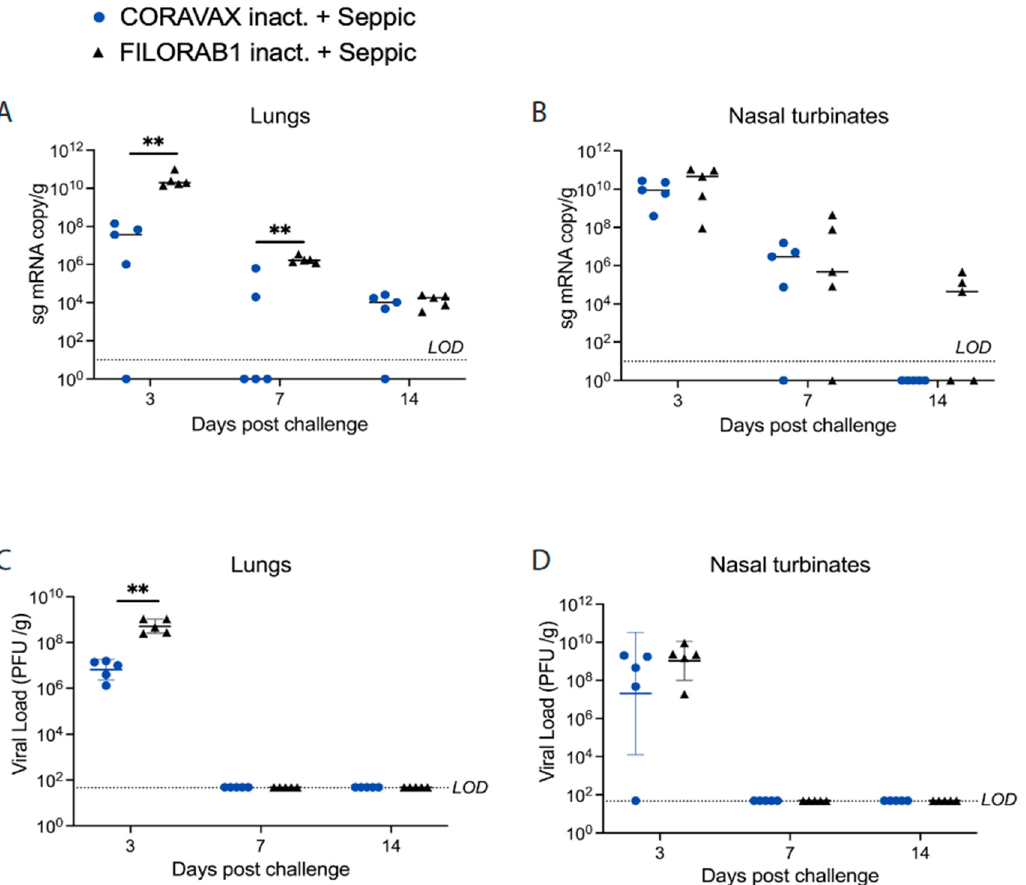
Figure 5. SARS-CoV-2 tissue viral load in hamsters. Hamsters were challenged intranasally with 10 4 PFU SARS-CoV-2, and five of the animals in each group were euthanized on days 3, 7, and 14 p.c. Right lungs ( A , C ) and nasal turbinates ( B , D ) from each animal were homogenized in media, and viral loads were determined by qRT-PCR (A, B) or by TCID 50 assays on Vero E6 cells ( C , D ). The limit of detection for the qRT-PCR assay is 10 copies. The limit of detection for the plaque assay is 50 PFU/mL per lung/nasal turbinate tissue. The CORAVAX vaccine group is shown in blue, and the FILORAB1 group is in black. Data represent mean ± S.D., n = 5 for FILORAB1 group days 3, 7, and 14 time points, and n = 5 for CORAVAX group days 3, 7, and 15 time points; p values were determined by Mann–Whitney test; p > 0.123 (ns), p < 0.033 (*), p < 0.002 (**), p < 0.001 (***). Only significant differences are